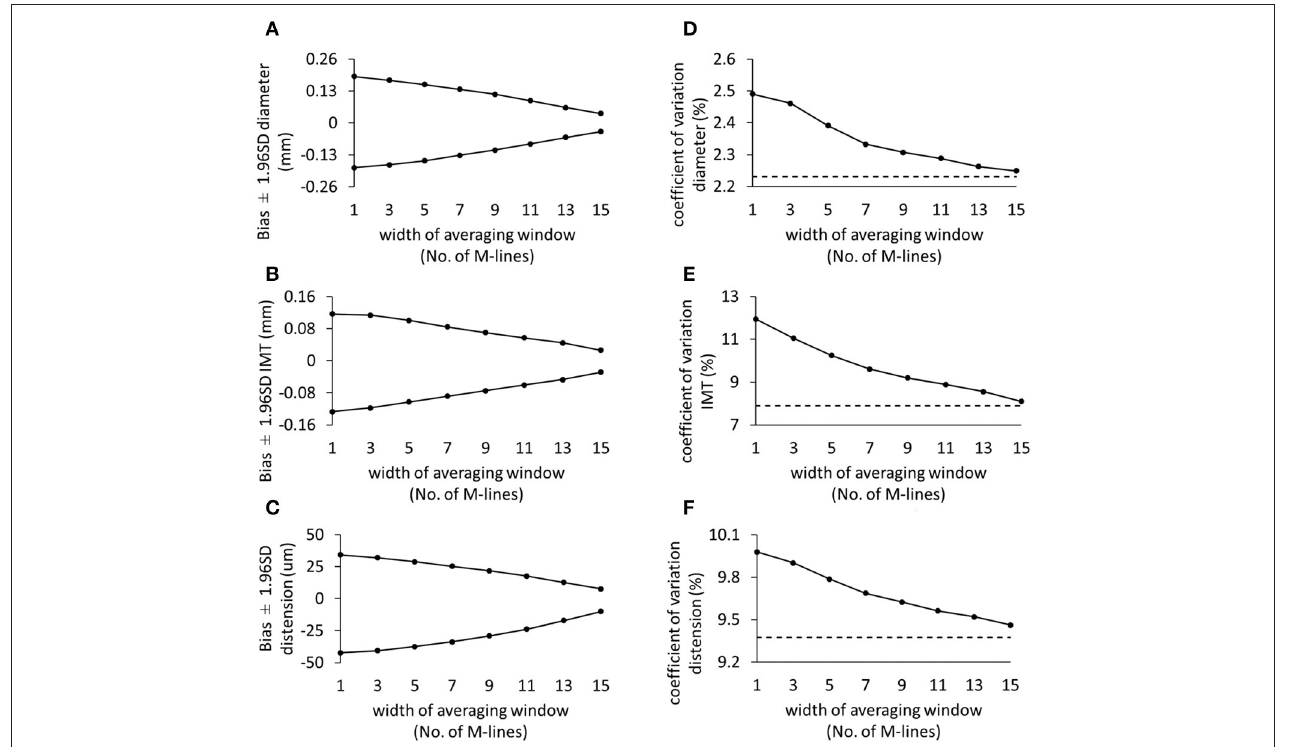
FIGURE 4 | The effect of increasing the spatial averaging window on the validity (A–C) and reproducibility coefficient of variation (D–F) for diameter, intima-media thickness, and distension, respectively. The dashed lines represent the reproducibility of the multiple M-line method (i.e., including all 17 M-lines). SD, standard deviation; IMT, intima-media thickness.